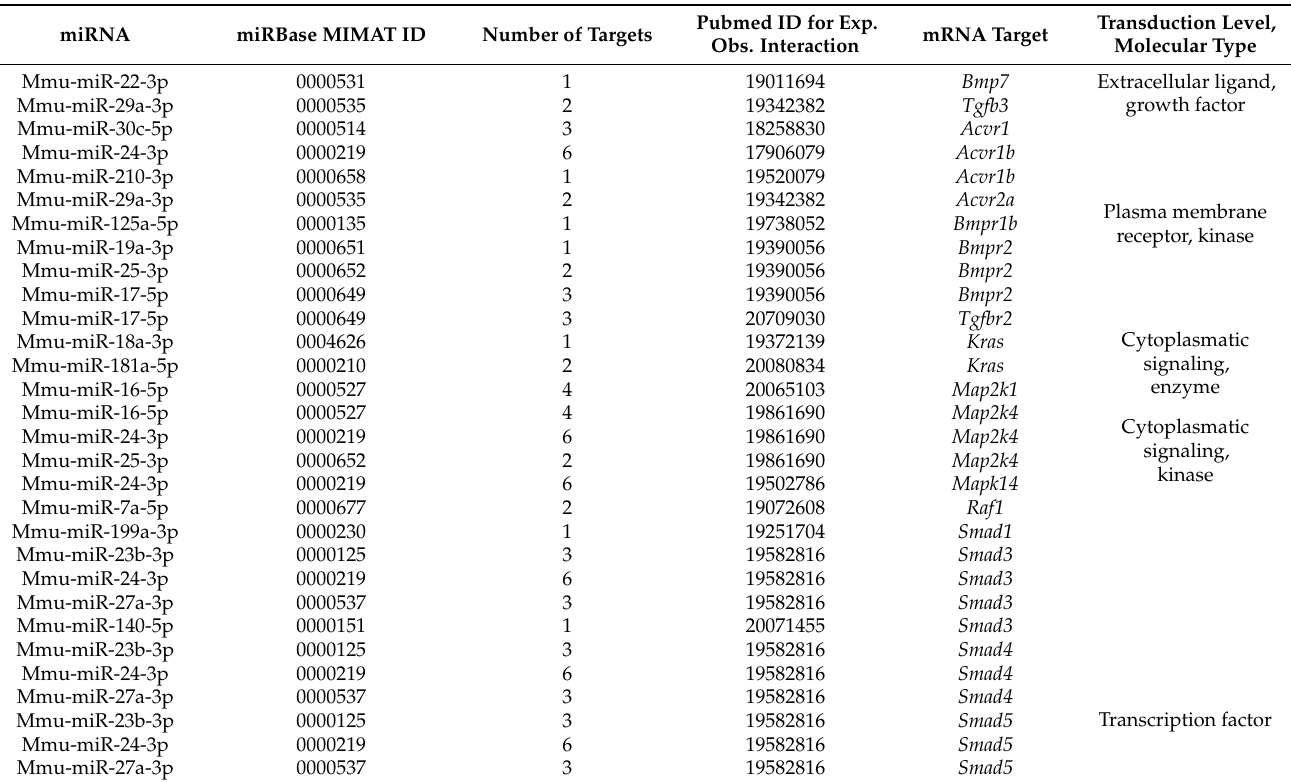
Figure 6. Mapping of ATII miRNAs to TGF- β signaling pathway components. This figure represents the canonical TGF- β signaling pathway from the Ingenuity ® pathway library. Orange arrows and outlines indicate ATII miRNA targeted members within molecule families (dark grey icons). Red arrowheads symbolize ATII miRNAs. For example, TGFBR2 is a member of the type II TGF- β receptors, and its mRNA is targeted by miR-17-5p. Compare Table 4 for an overview of interactions. Table 4. Mapping of ATII-expressed miRNAs to TGF- β pathway signaling